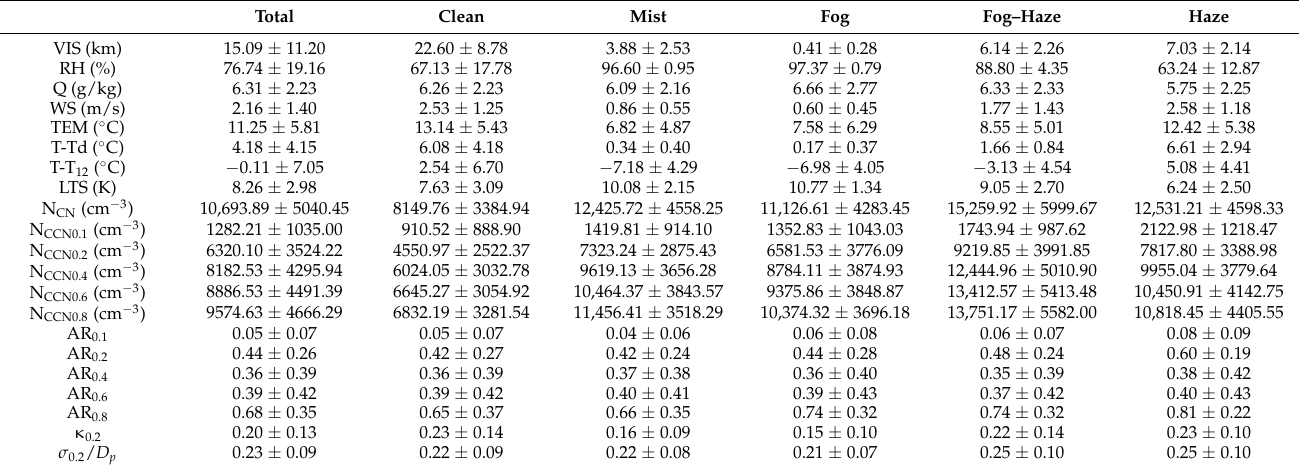
Table 2. Average of various parameters in different weather